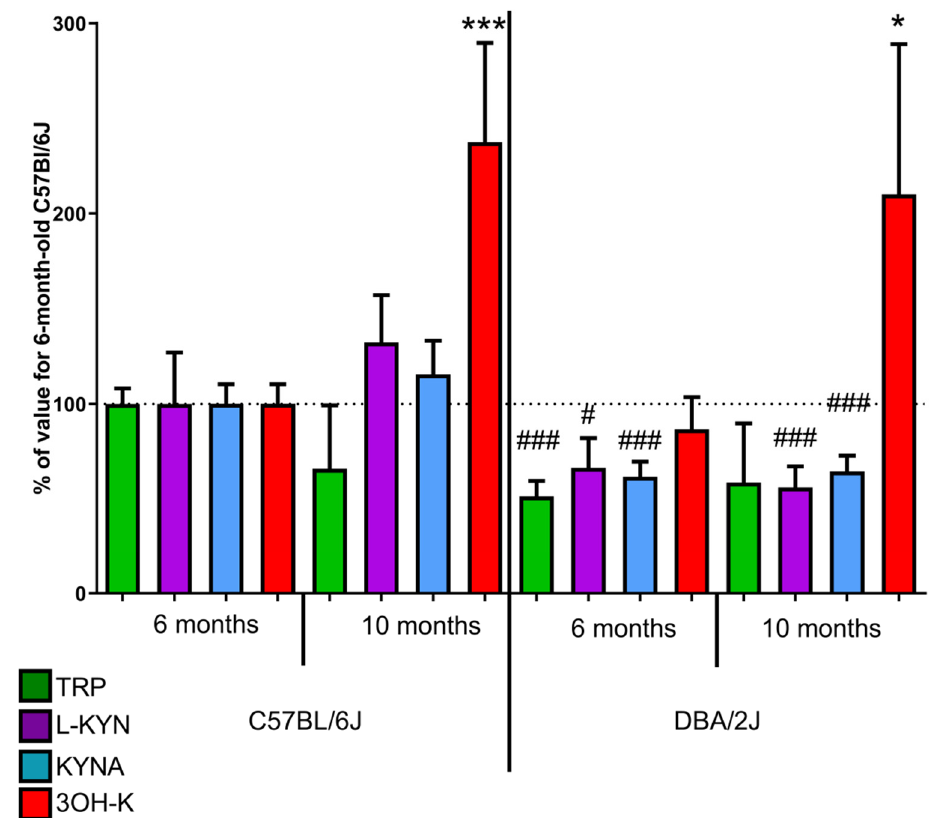
Figure 2. The levels of tryptophan (TRP), L-kynurenine (L-KYN), kynurenic acid (KYNA), and 3-hydroxykynurenine (3OH-K) in the retinas of C57BL/6 and DBA/2J mice. Values are expressed as a percentage of TRP, L-KYN, KYNA, or 3-OH-K concentrations in samples from 6-month-old C57Bl/6 mice. # p < 0.05, ### p < 0.001 DBA2J vs. C57Bl/6; * p < 0.05, *** p < 0.001 10 months vs. 6 months.